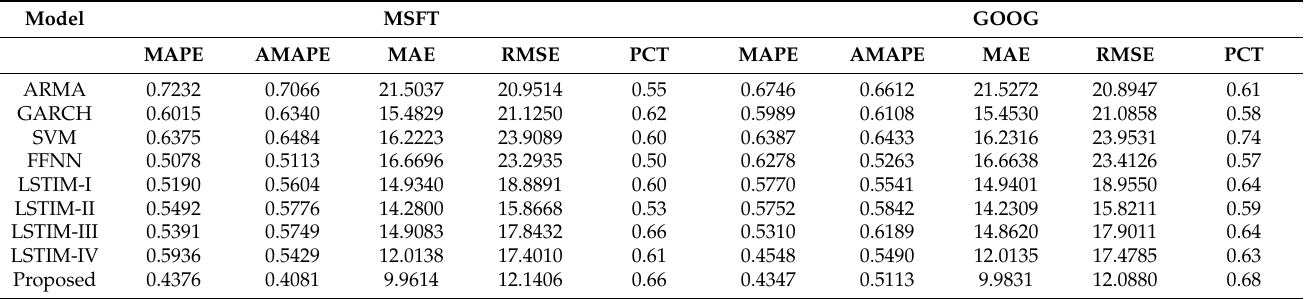
Table 6. Prediction performance for 75 days: MSFT and GOOG.